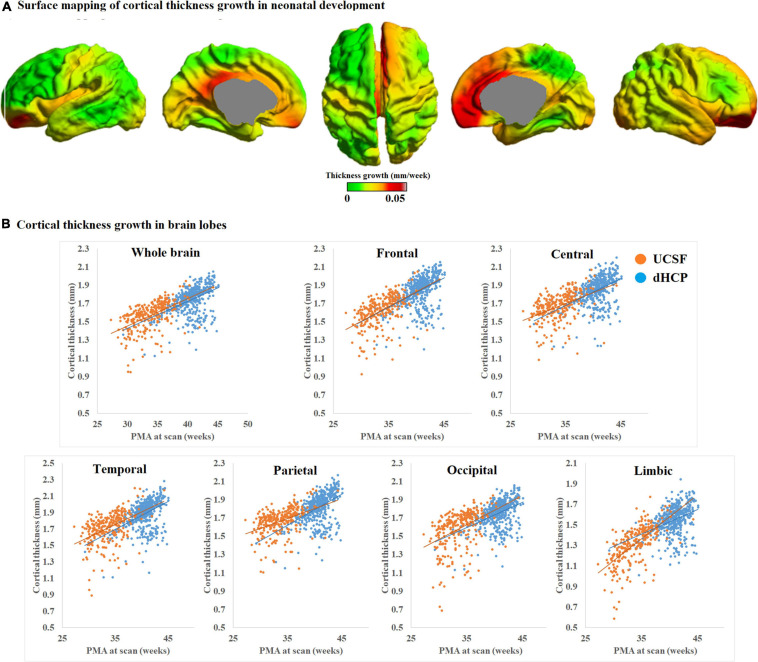
(A) Mean cortical thickness significantly and positively correlates with PMA at scan (p < 0.001). Cortical thickness grows the most rapidly in brain regions near the cingulate cortex but the slowest in brain regions near the inferior temporal cortex. (B) Trajectory of cortical thickness development in whole brain and six anatomical lobes, for both the UCSF and dHCP datasets.